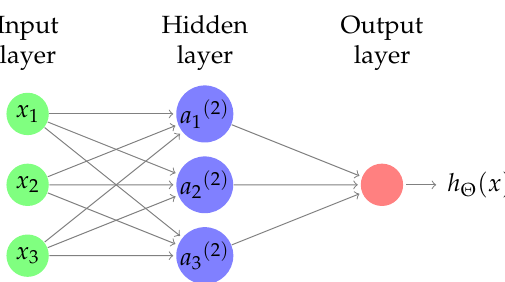
Figure 1. Neural network scheme with the input layer, hidden layer and output